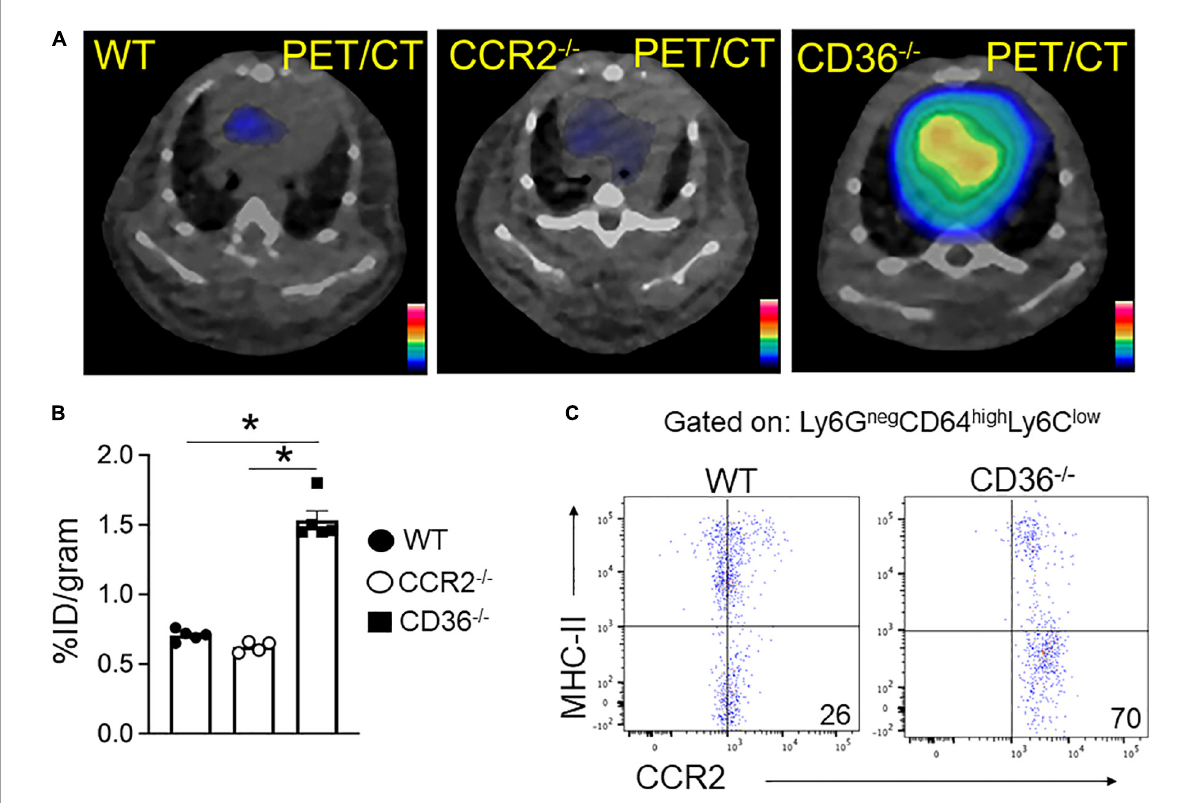
FIGURE6 68 Ga-DOTA-ECL1i PET/CT imaging the infiltration of CCR2 + monocyte/macrophages in hearts. (A,B) Representative 68 Ga-DOTA-ECL1i PET/CT images and quantitative analysis showed higher tracer accumulation in the heart of CD36 − / − ( n = 5) compared with WT mice ( n = 5) and CCR2 − / − mice ( n = 4/group). (C) Flow cytometric analysis of CCR2 expression in macrophages isolated from WT and CD36 − / − hearts ( n = 3/group). All data are means ± SE with n representing the number of mice per group. Statistical significance is determined by One-way ANOVA. * p <